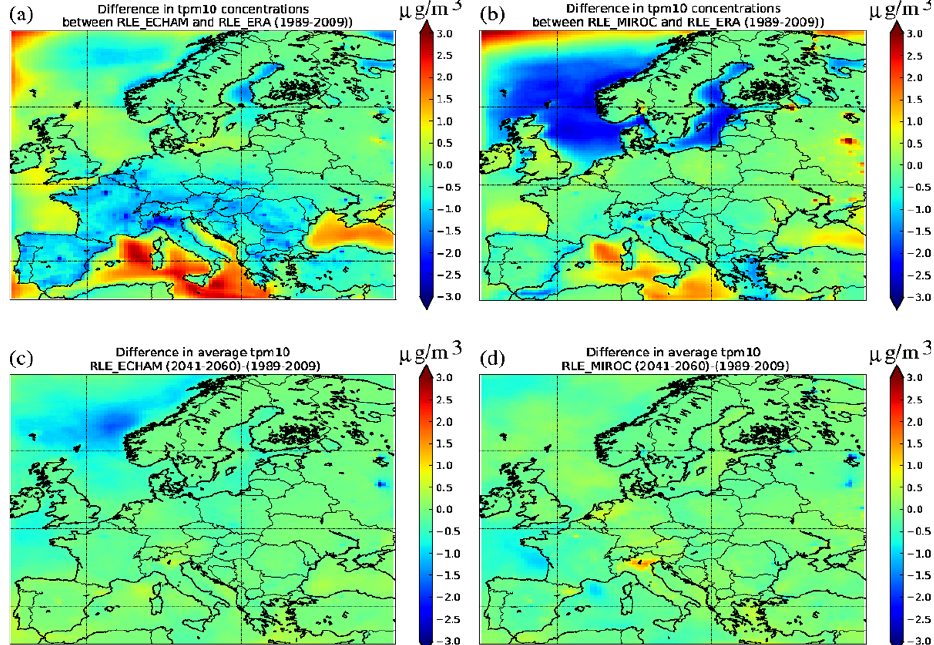
Fig. 9. Like Fig. 8, but showing differences between 20-yr total PM 10 concentrations.